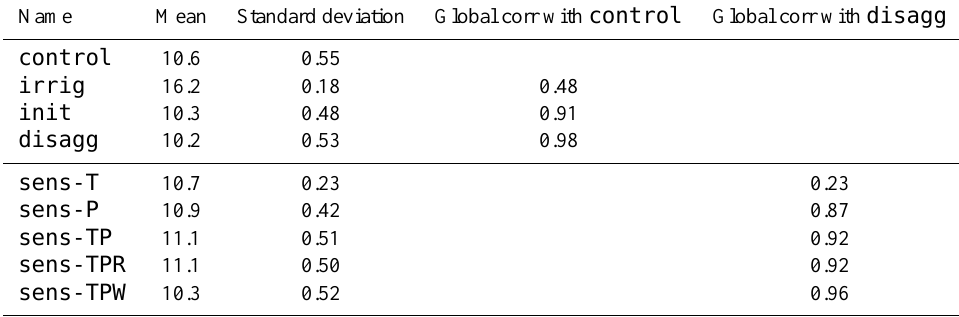
Table 2. Results from the global runs described in Sect. 3. First column is the run name; second column is the mean maize yield (in Mgha − 1 ); third column is the standard deviation of the annual global yield time series (in Mgha − 1 ). The fourth column gives the Pearson correlation coefficient with the global yield in the control run, and the fifth column gives the Pearson correlation coefficient with the global yield in the disagg run. All results have been weighted as described in Sect. 4. These results are presented as scatter plots in Appendix